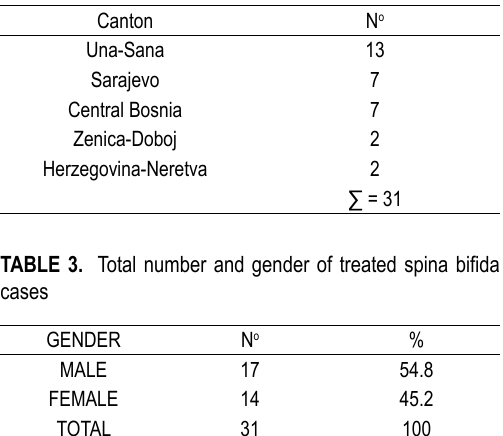
Table 2. Frequency of spina bifida in the observed geo - graphical region